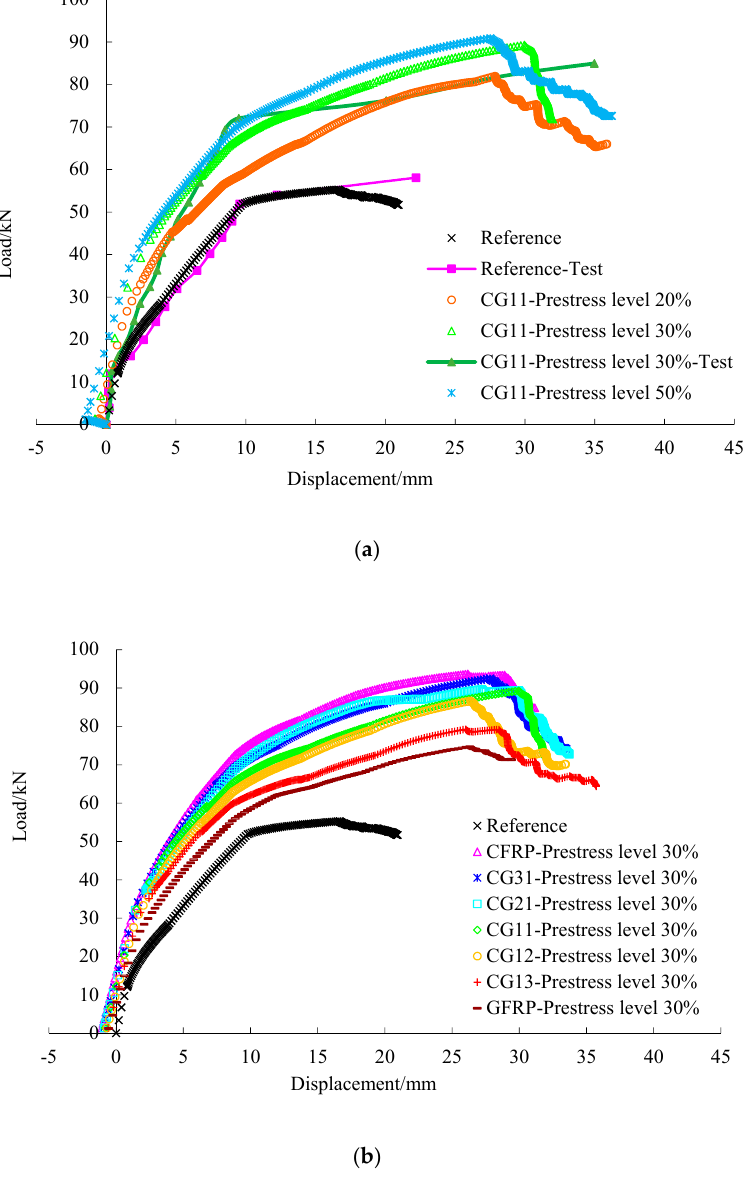
Figure 13. Load-deflection curves: ( a ) comparison between different prestress levels; ( b ) comparison between different hybrid ratios.